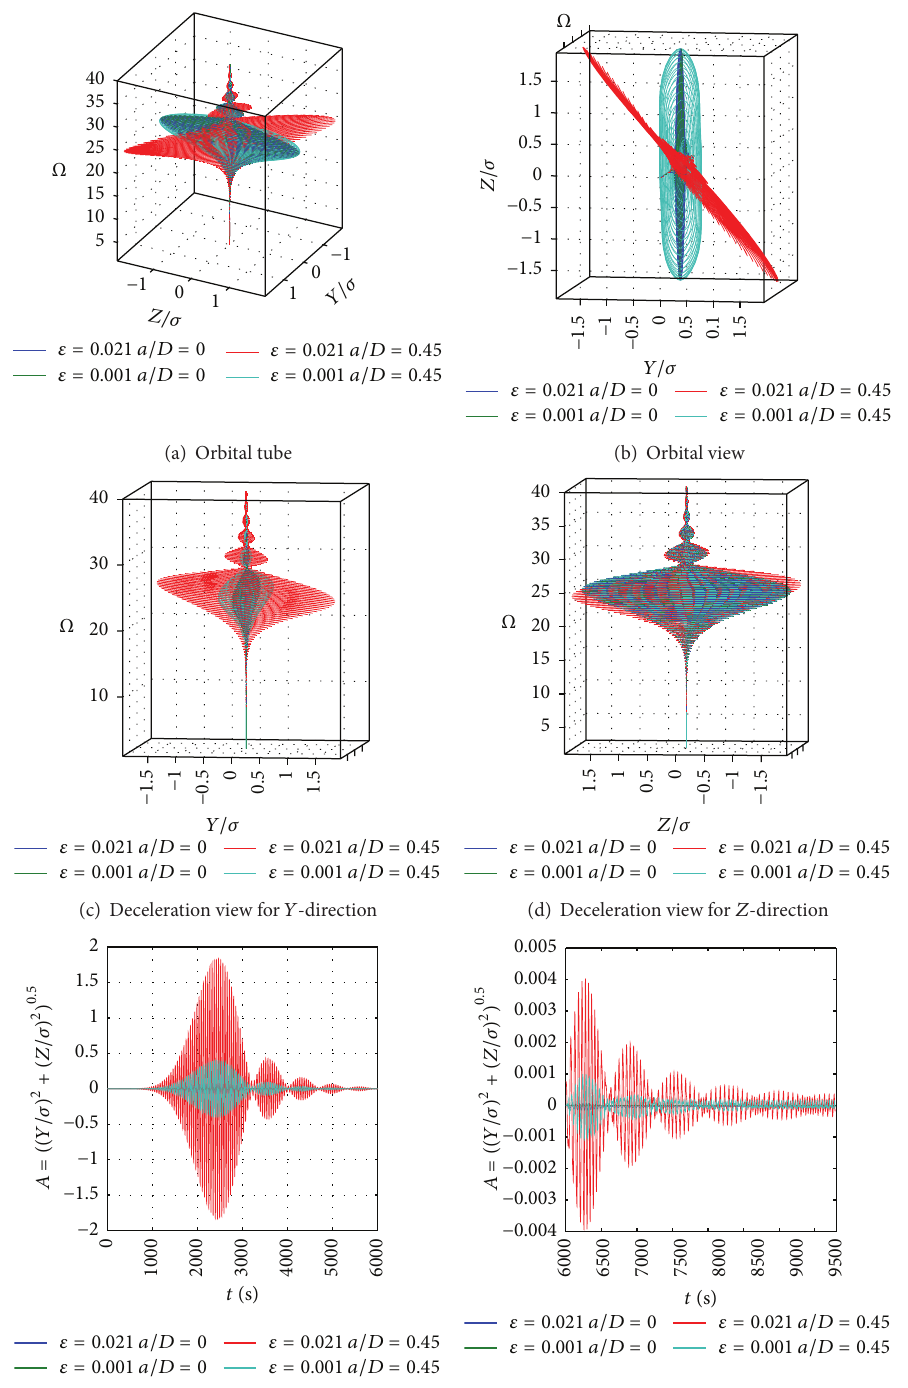
Figure 5: Nondimensional unbalance response of the Jeffcott rotor with a breathing crack with different mass eccentricity ratio 𝜀 = 0 . 021 ; 0 . 001, crack depth ratio 𝑎/𝐷 = 0 . 45 ; 0, and unbalanced orientation angle 𝛽 = 𝜋/ 2: (a) orbital tube; (b) orbital view; (c) deceleration view for 𝑌 -direction; (d) deceleration view for 𝑍 -direction; (e) compound response 𝐴 = √ (𝑌/𝜎) 2 + (𝑍/𝜎) 2 within time interval from 0 sec to 6000 sec; (f) compound response 𝐴 = √ (𝑌/𝜎) 2 + (𝑍/𝜎) 2 within time interval from 6000sec to 9800